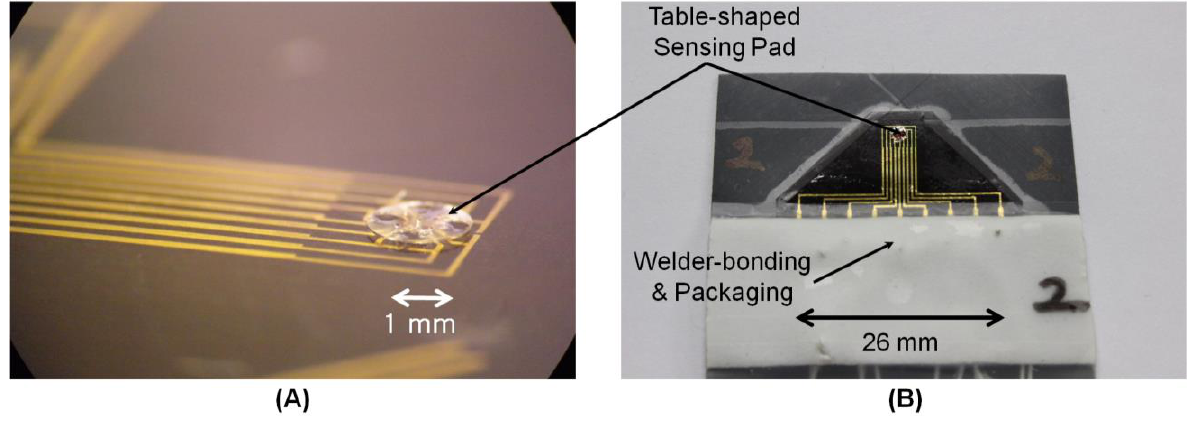
Figure 7. ( A ) Fabricated sensor body and table-shaped sensing pad and ( B ) Packaged tactile sensor after welder